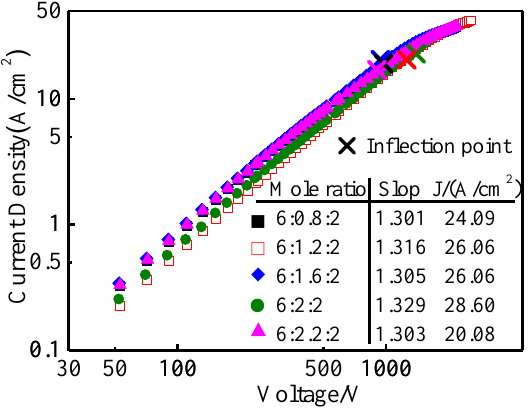
Figure 6. Pulse emission curves of 6BaO · xCaO · 2Al 2 O 3 aluminates barium tungsten cathodes. Combined with the molten phase results of 6BaO · xCaO · 2Al 2 O 3 aluminates, it could be